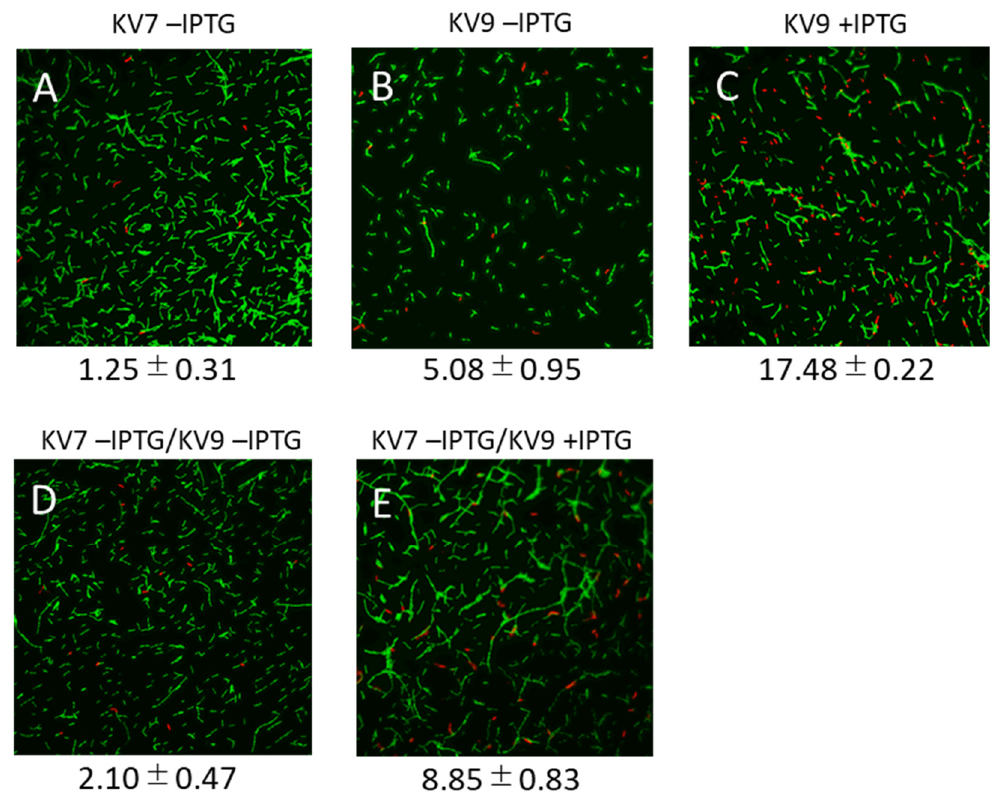
Figure 3. LIVE/DEAD staining of strains KV7 and KV9. KV7 ( A ) and KV9 ( B , C ) were grown individually to OD 600 = 0.5 with ( C ) and without ( A , B ) IPTG, and then subjected to the LIVE/DEAD staining to distinguish the dead cells in red and living ones in green under 400 × microscopy. The same volumes of KV7 and KV9 cultures were mixed for conjugation and stained ( D , E ), where KV9 was grown with ( E ) and without ( D ) IPTG. The values beneath each panel are the percentage of dead cells calculated from four independent experiments with similar results.